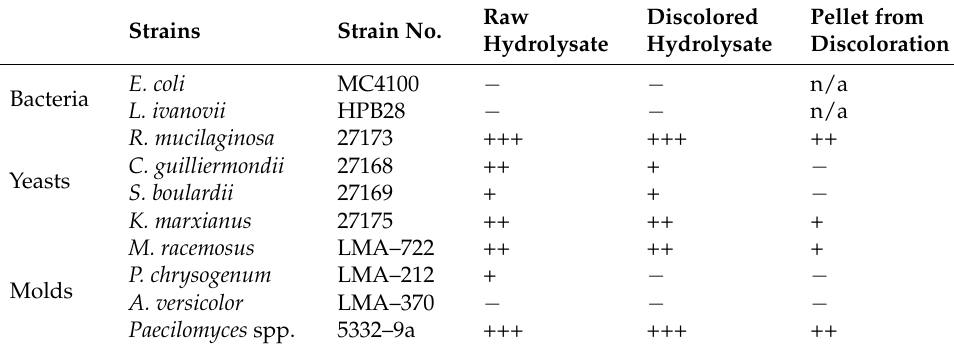
Table 5. Antimicrobial activity of porcine cruor hydrolysates.